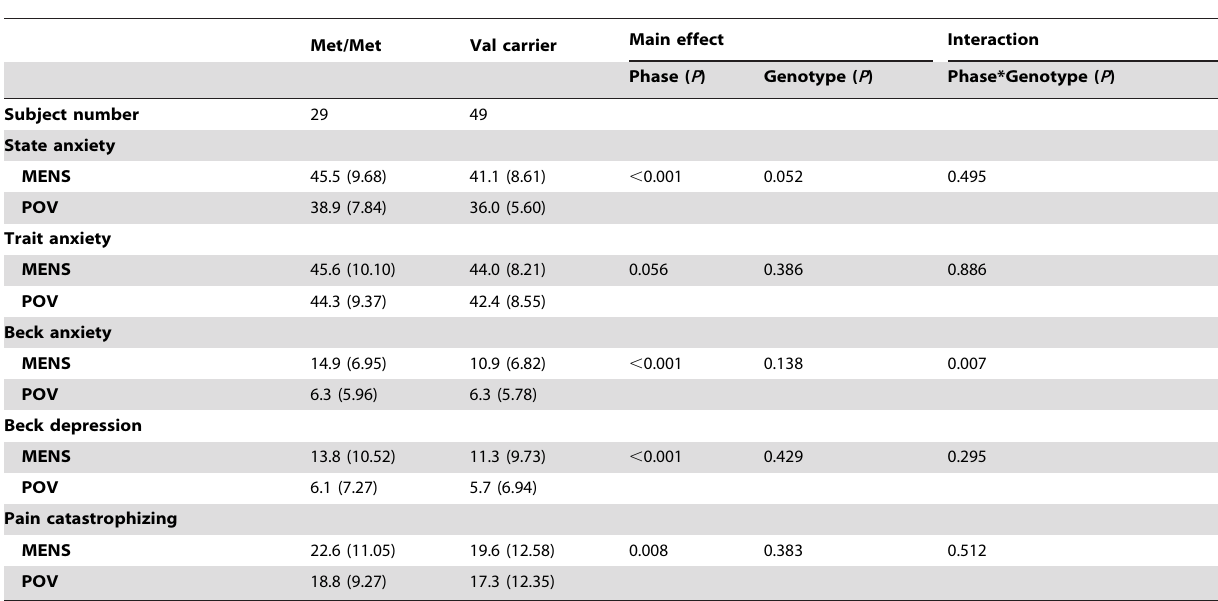
Table 5. Results of repeated-measures ANOVA of psychological measurements: effects of menstrual cycle and BDNF genotype in the PDM